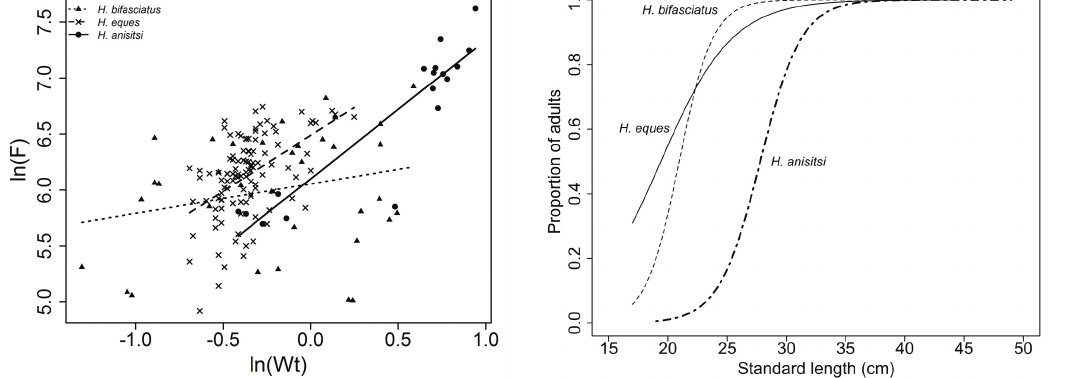
Figure 3. Proportion of adults considering the standard length of Hyphessobrycon bifasciatus , H . eques , and H . anisitsi